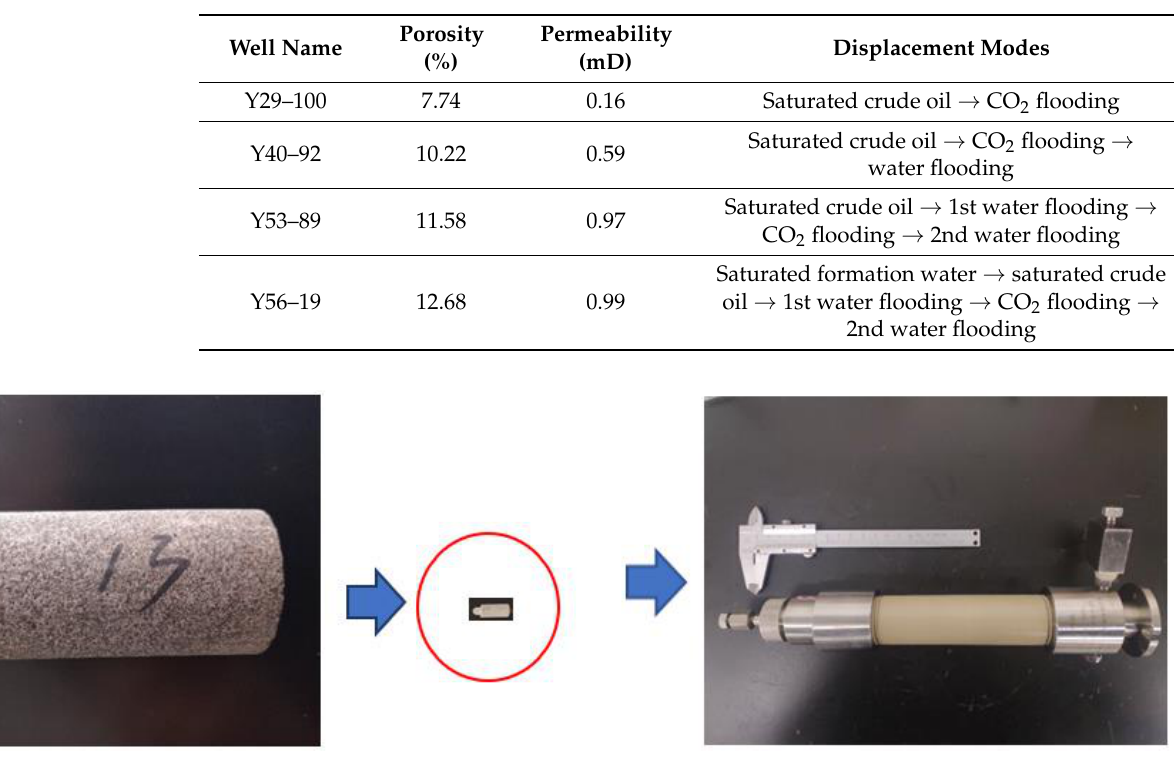
Figure 2. The flow chart of preparing the small core sample for CT scanning.